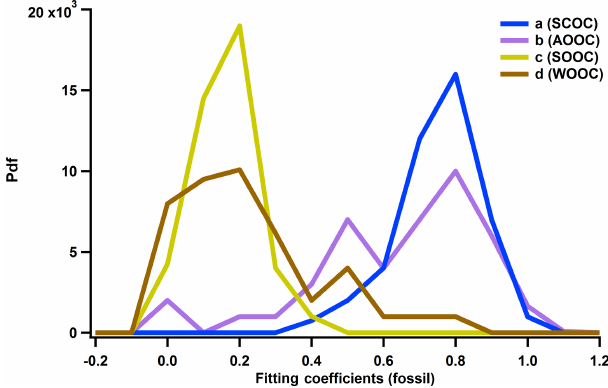
Figure 8. Probability density functions of the fitting coefficients of the relative fossil contributions: SCOC in blue, AOOC in purple, SOOC in yellow and WOOC in light